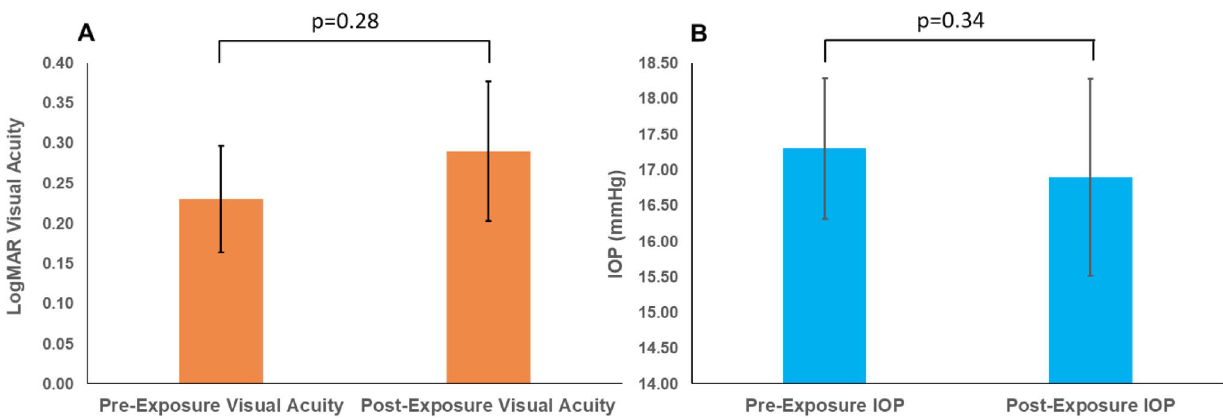
Figure 3. Effects of senolytics on visual acuity and intraocular pressure. Senolytic drug exposure was not associated with significant changes in visual acuity ( A ) or intraocular pressure (IOP) ( B ). Error bars denote standard